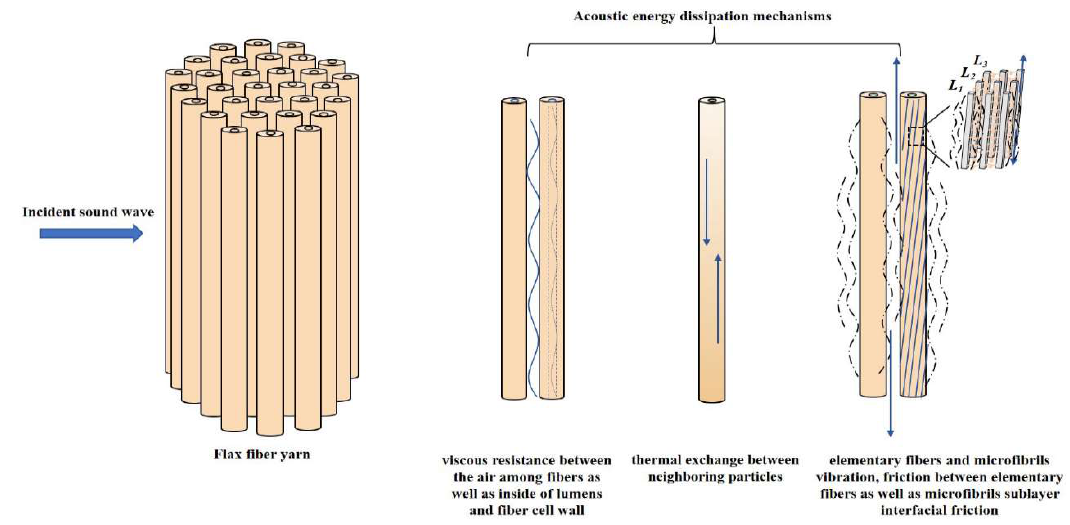
Figure 6. Acoustic energy dissipation mechanisms of flax fiber yarns.